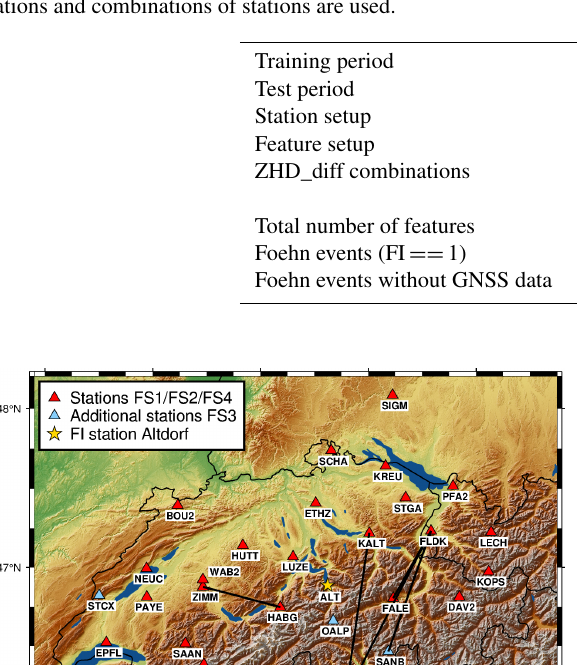
Table 1. Default setup used for the cross-validation and feature setup 1 (FS1). For features not outlined in a specific row, by default, all stations and combinations of stations are used.